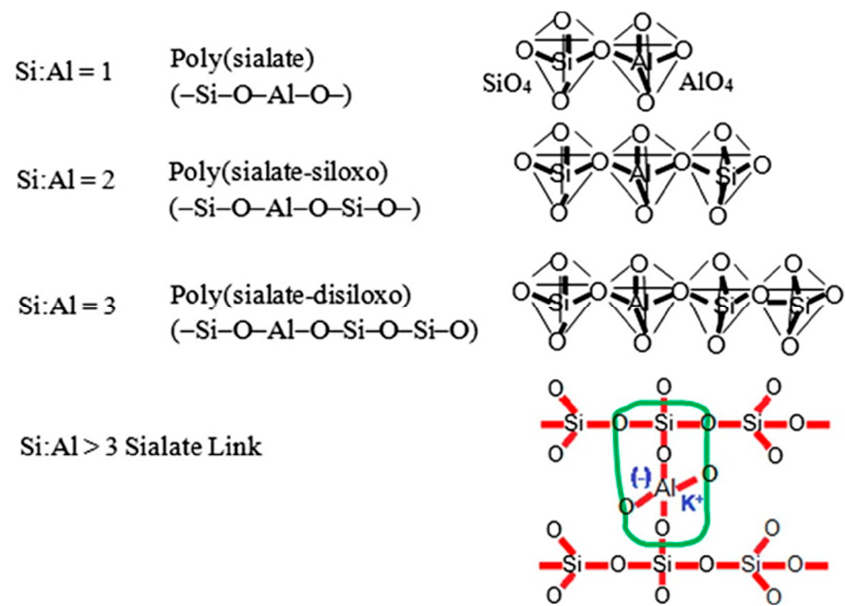
Figure 15. Different geopolymer systems [86].